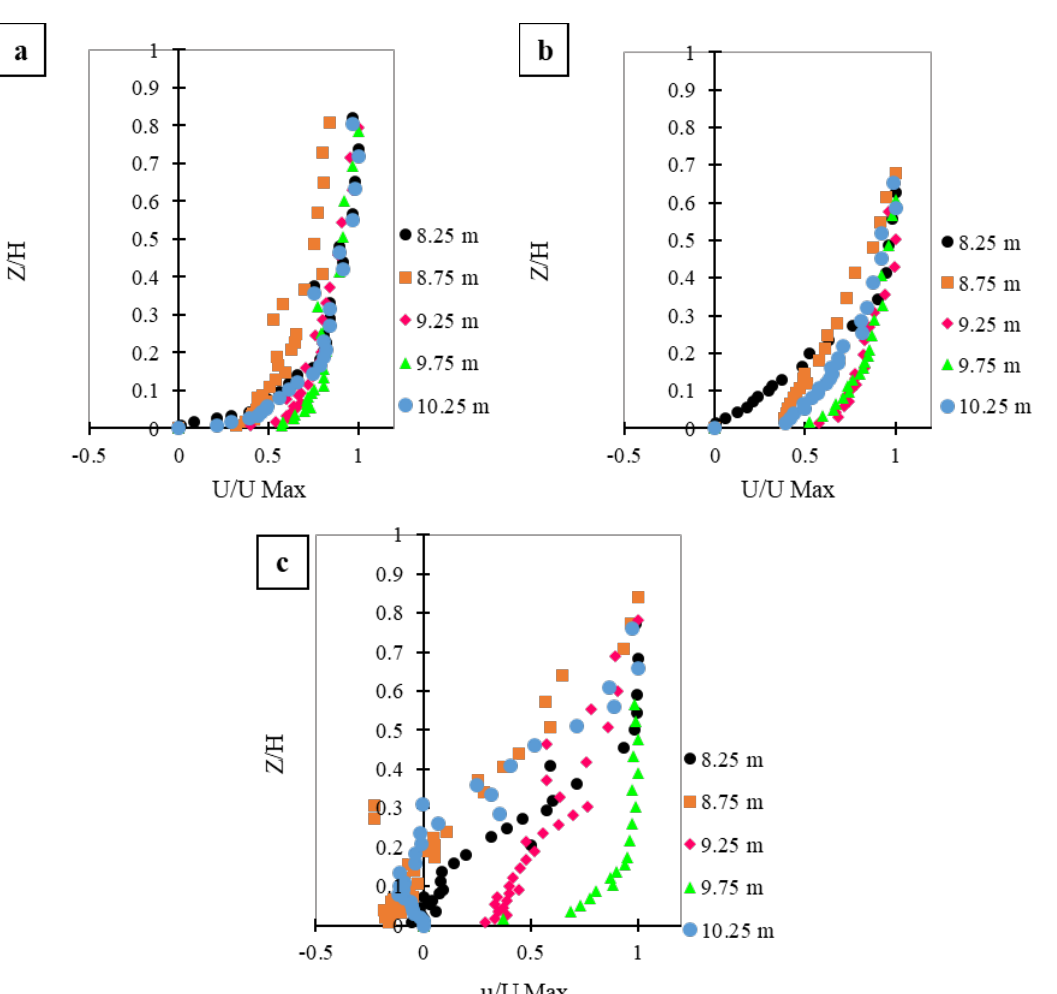
Figure 11. Velocity profiles for: ( a ) series “ a ” test on the central axis of the channel with an angle of 5° and aspect ratio of less than five, ( b ) series “ b ” test on the central axis of the flume with an angle of 5° and aspect ratio of more than five, and ( c ) series “ c ” test on the central axis of the flume with an angle of 20° and aspect ratio of less than five. In the experiments with angles of 20°, in the pool area (x = 8.25 m and x = 8.75 m), the maximum velocity occurs at 𝑍 = 0.25, and in the riffle area (x = 9.25 m), the maximum velocity was observed at 𝑍 =